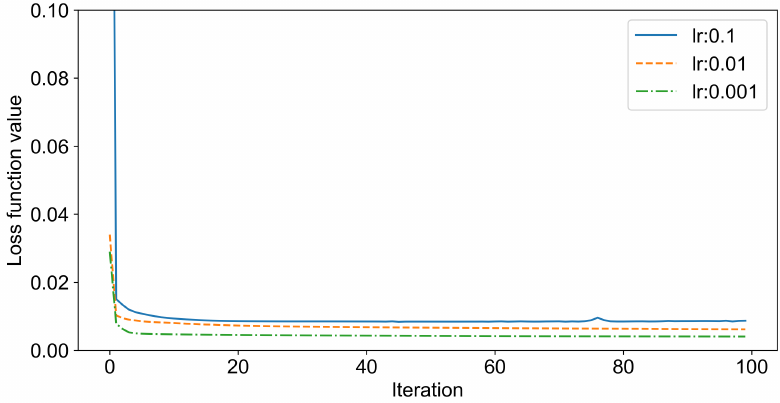
Figure 5. The comparison of training loss at different learning